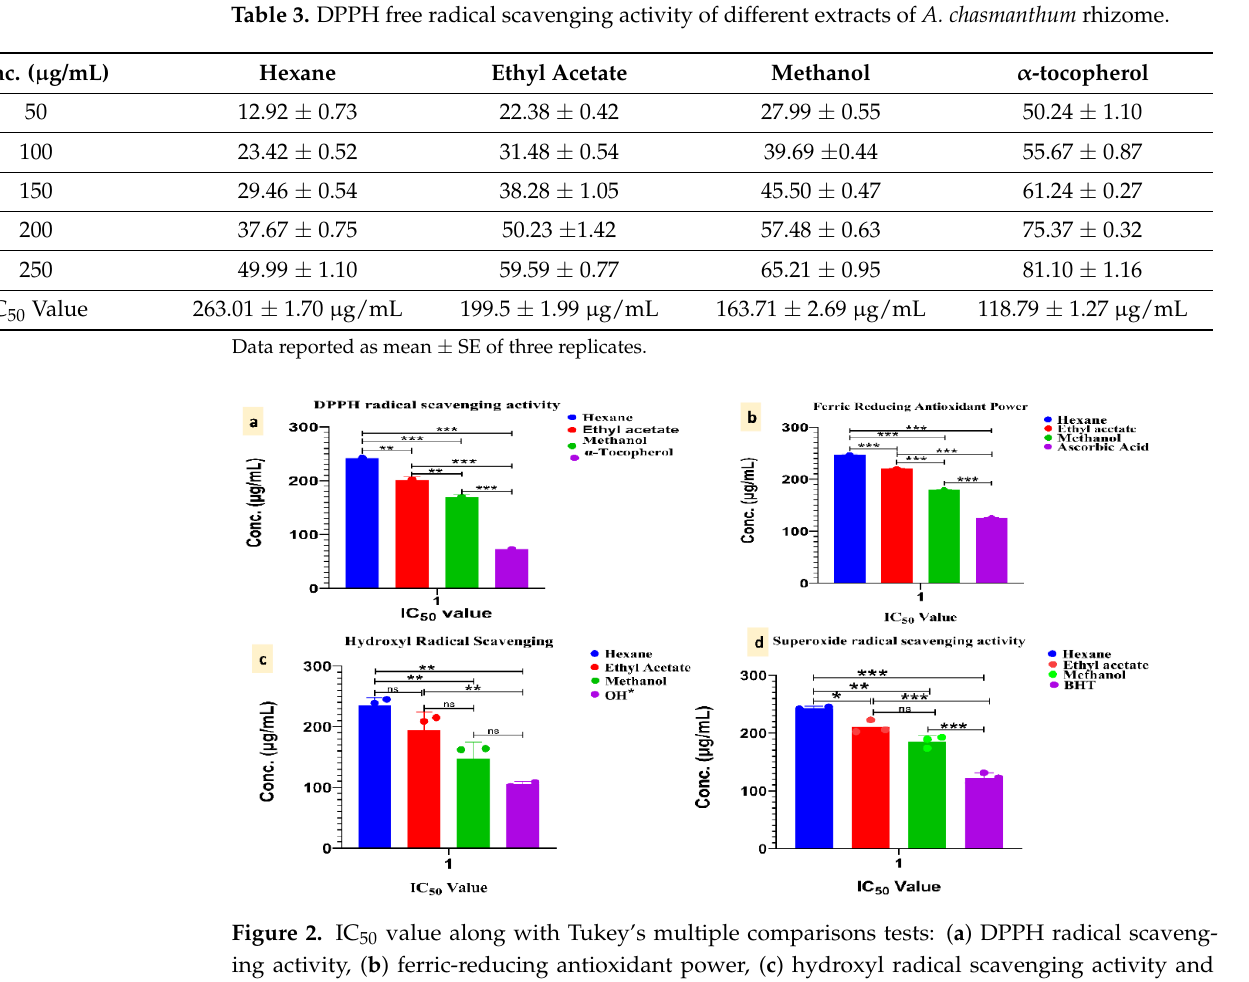
Table 4. Ferric-reducing antioxidant power (FRAP) values for A. chasmanthum rhizomes.